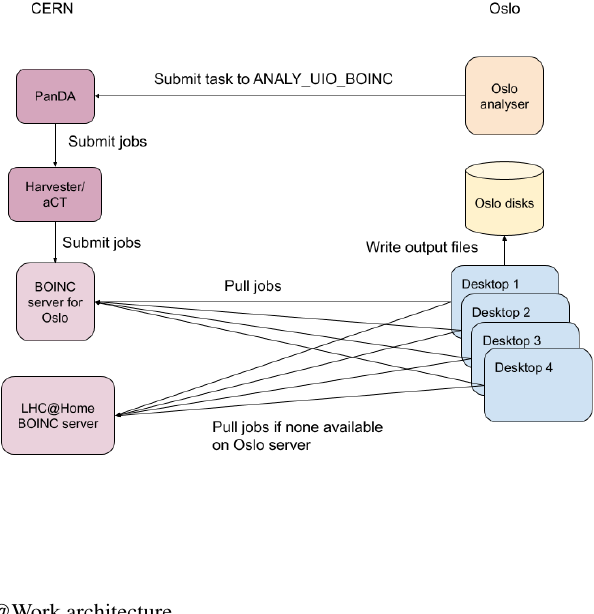
Figure 3. ATLAS@Work